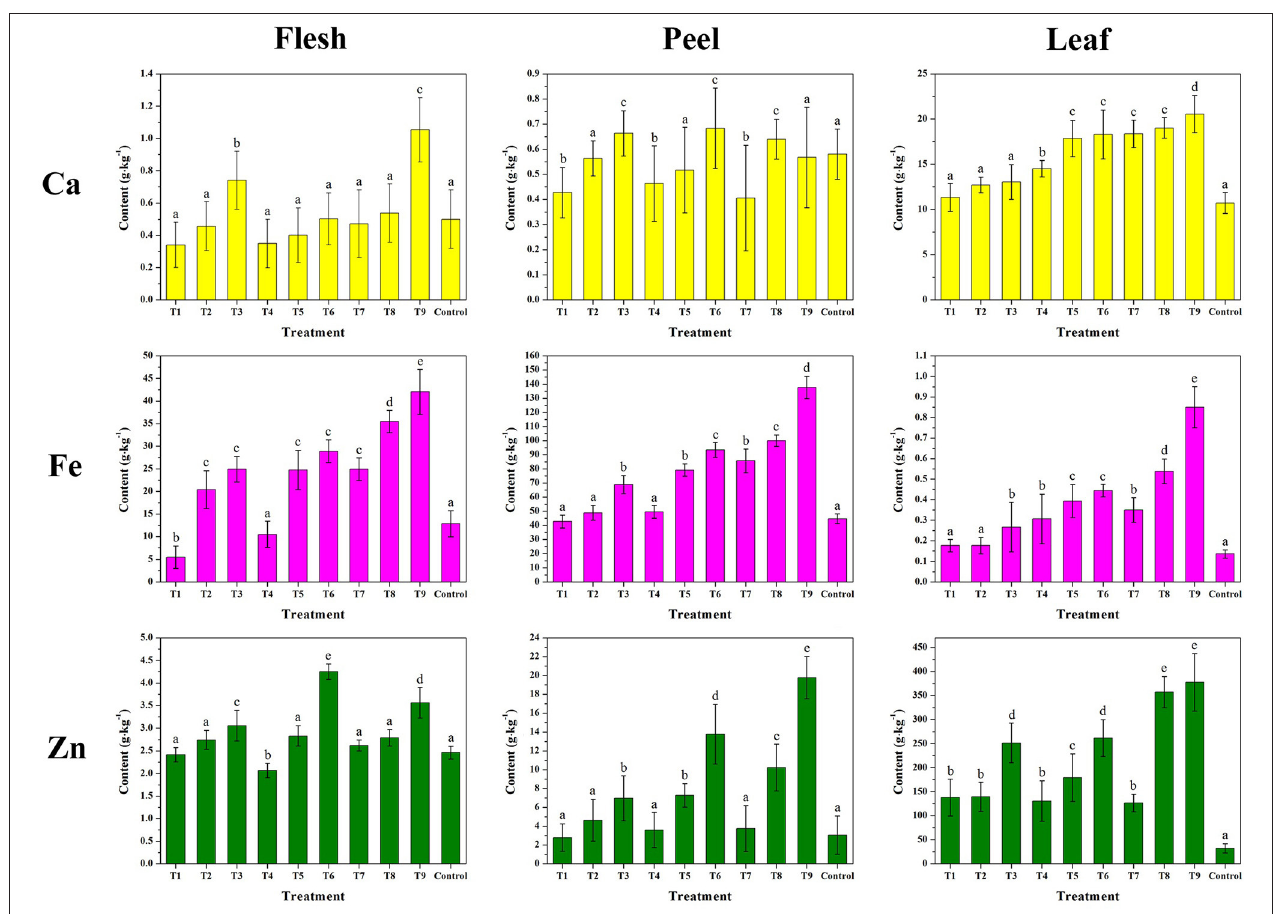
FIGURE 10 | Effects of MRPs–Ca/Fe/Zn on the mineral nutrients of fleshes, peels, and leaves of “Fuji” apple.